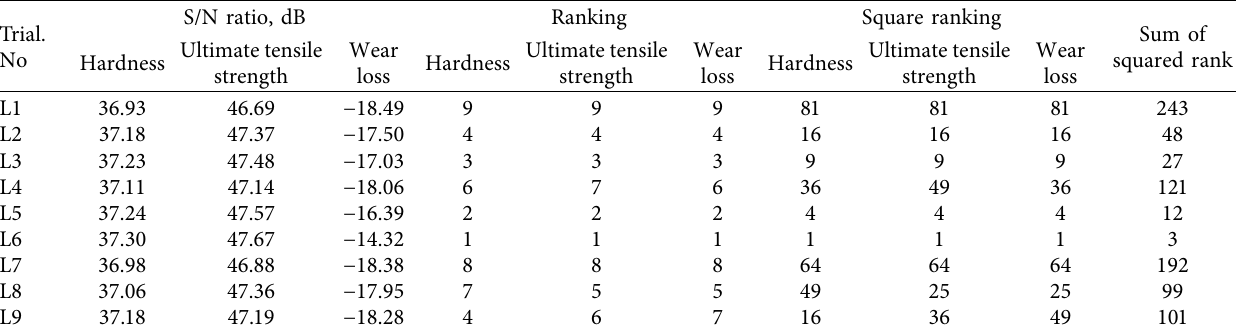
Table 9: Super ranking concept’s result summary.